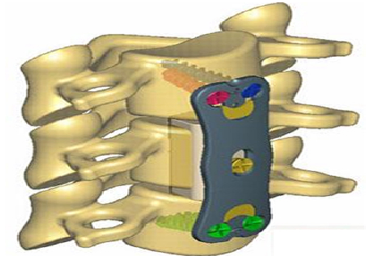
Figure 4 – Plates for the front neck spine Metode izrade i obrade materijala za izradu fiksatora u